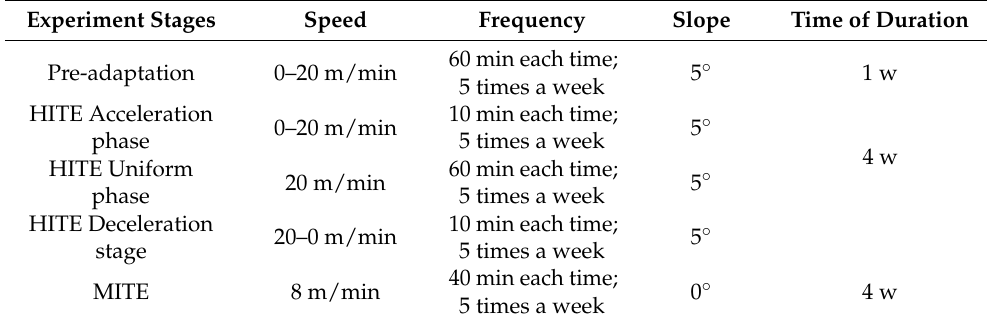
Table 2. Treadmill exercise